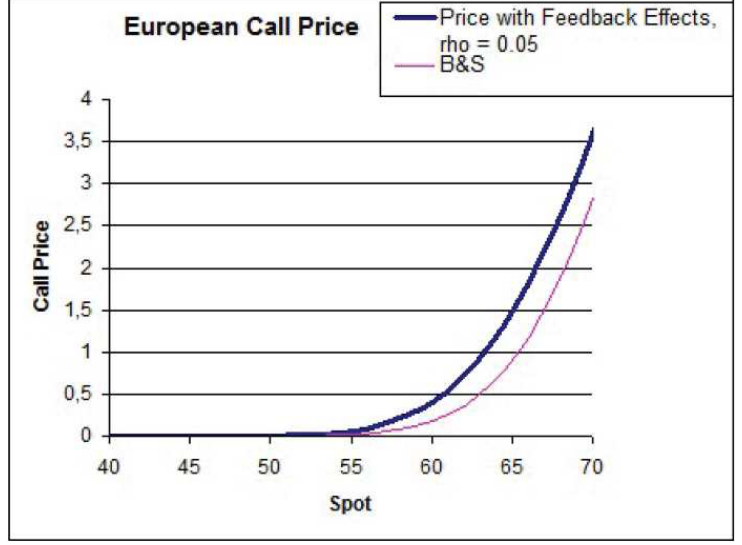
Fig. 9. European call